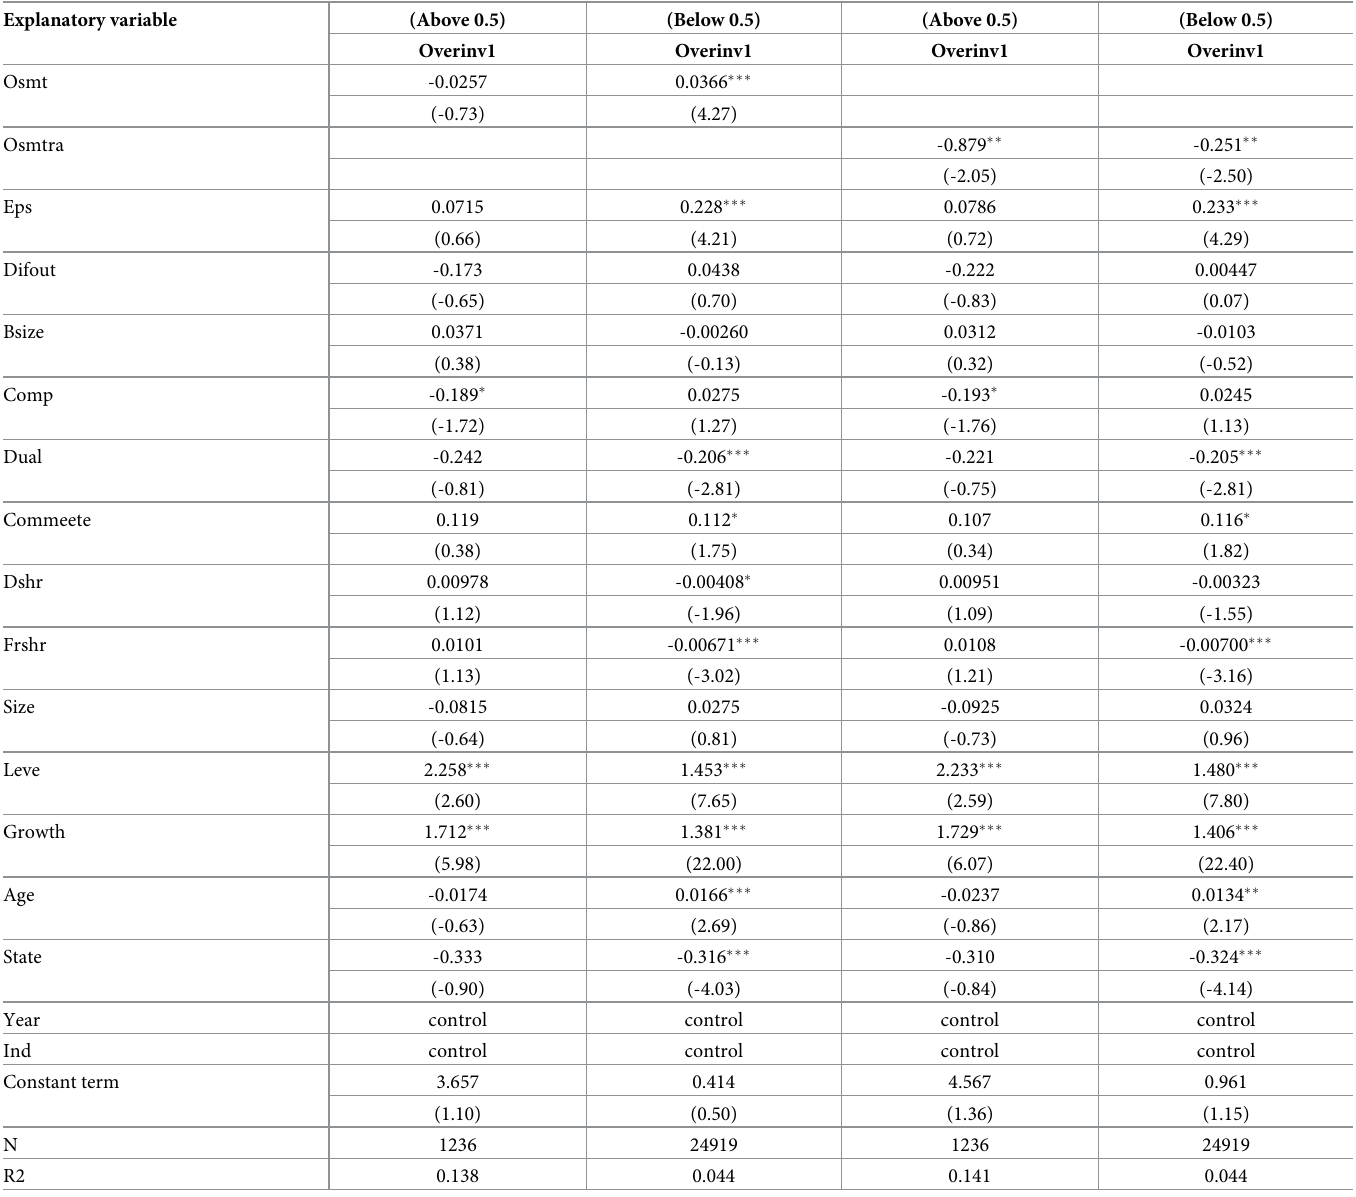
Table 6. Different proportion of independent